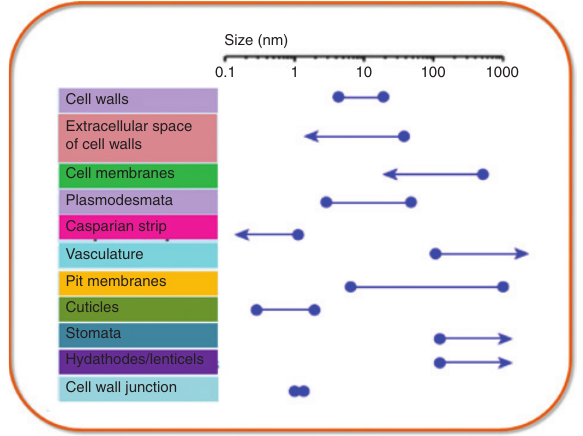
Figure 5: Size exclusion limits (SELs) of various plant tissues (barri- ers) for the uptake of nanoparticles (Reprinted from Wang et al. [67] with copyright permission from Elsevier).